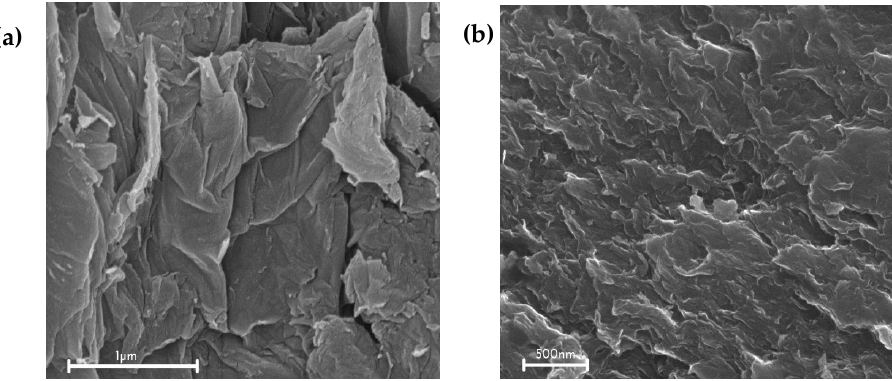
Figure 8. FESEM images of ( a ) GO and ( b ) rGO (magnification